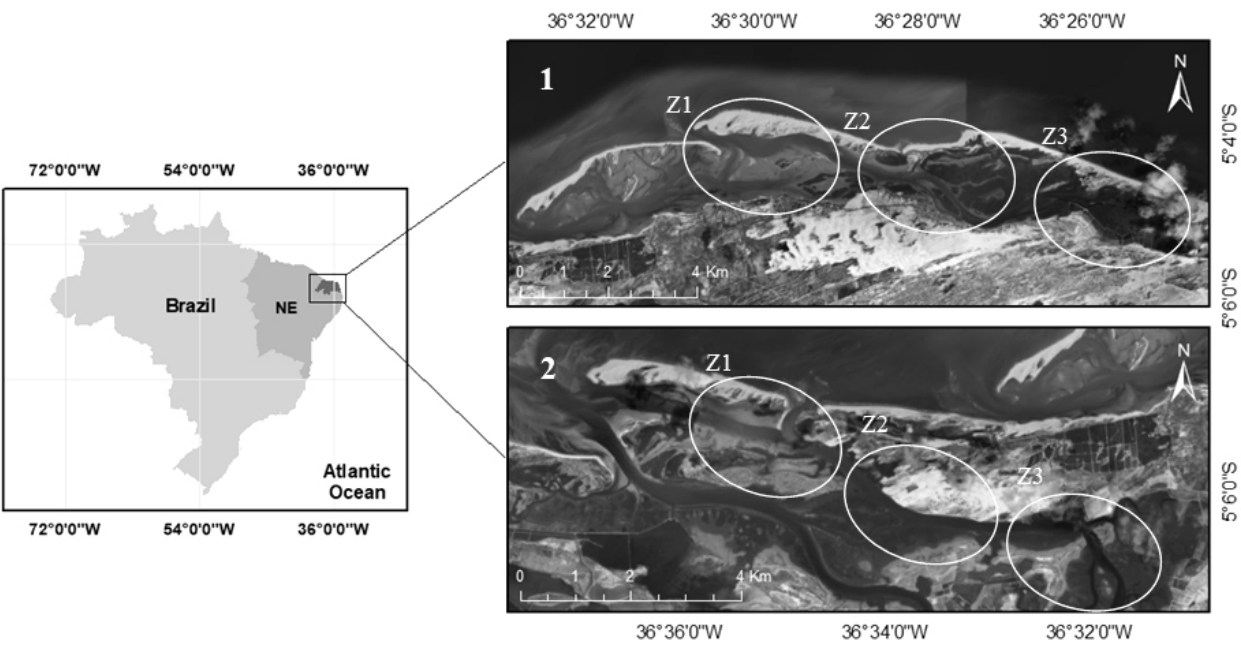
FIGURE 1 | Map of the two study areas, Tubarão (1) and Casqueira (2) river estuaries. The insert map indicates the sampling sites (zones) in both estuaries: Z1 = Lower zone, Z2 = Middle zone and Z3 = Upper